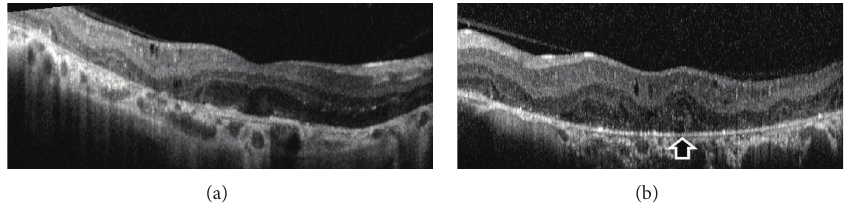
Figure 6: Optic coherence tomography. (a) Right eye, cystoid changes, and concurrent vitreomacular adhesion. (b) Left eye, cystoid changes, outer retinal tubulation (black arrow), and vitreomacular